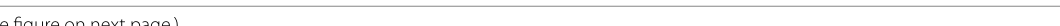
file 1: Figure S1). BLIP itself has no bacterial killing